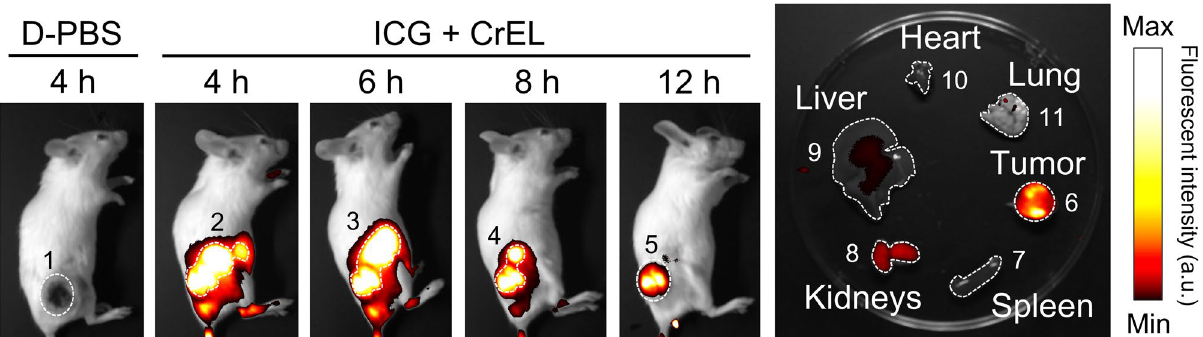
Figure 3. Pharmacokinetic evaluation of CrEL NPs by in vivo bioimaging. A near-infrared fluorescent dye ICG was encapsulated in CrEL NPs instead of KS-58 for pharmacokinetic studies. ICG-derived fluorescence was measured with an in vivo imaging system. White dot lines represent region of interest for the quantification of images with statistical analysis (1: Area = 956, Mean = 0, 2: Area = 1937, Mean = 227, 3: Area = 1936, Mean = 226, 4: Area = 1182, Mean = 178, 5: Area = 956, Mean = 136, 6: Area = 1052, Mean = 102, 7: Area = 853, Mean = 0, 8: Area = 855, Mean = 39, 9: Area = 4856, Mean = 5, 10: Area = 451, Mean = 0, and 11: Area = 1205, Mean =